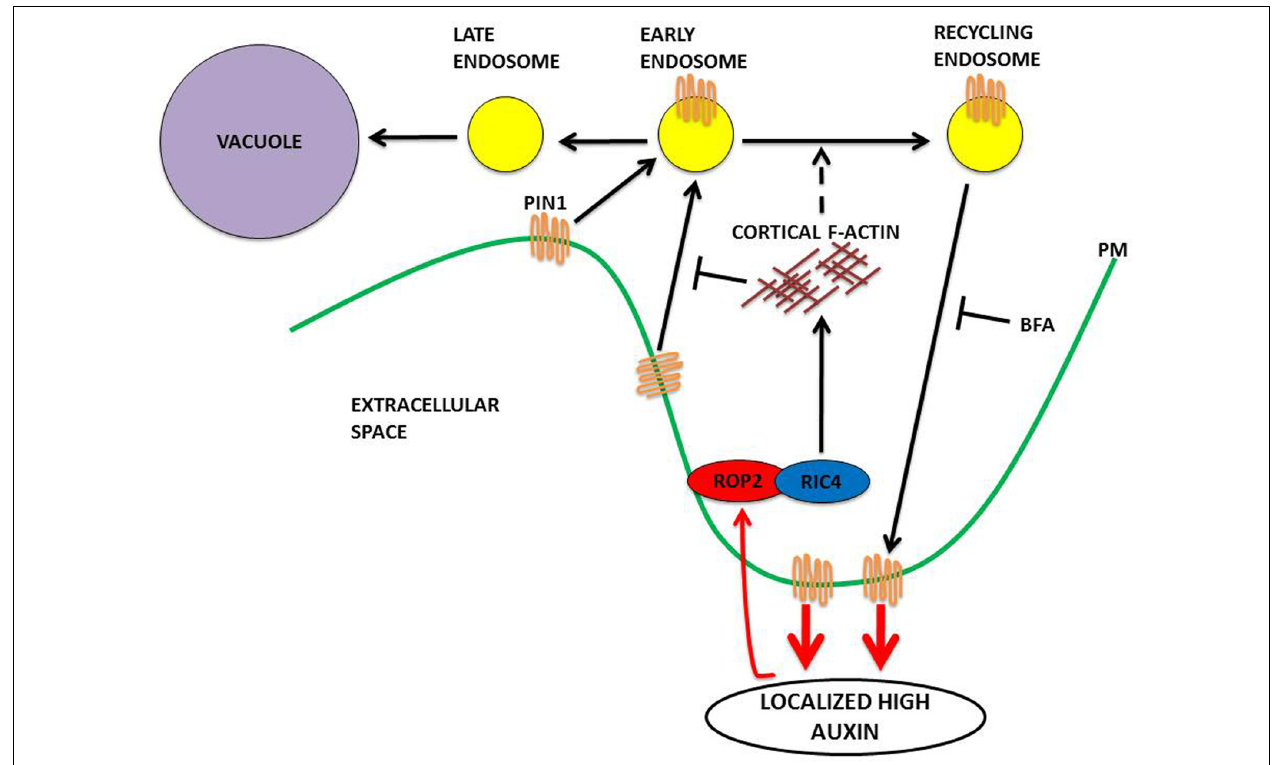
recycling endosomes (Brefeldin A inhibits ADP ribosylation factor GEF and prevents endosomal recycling, the accumulation of internalized PIN1 in aggregates known as BFA bodies in plant cells). Endocytosed material can then be recycled back to the PM. Material maintained in early endosomes as they mature becomes internalized in late endosomes.The multivesicular structure of the late endosomes allows membrane fusion with the vacuole. Proteins within the late endosomes are delivered to the vacuole for